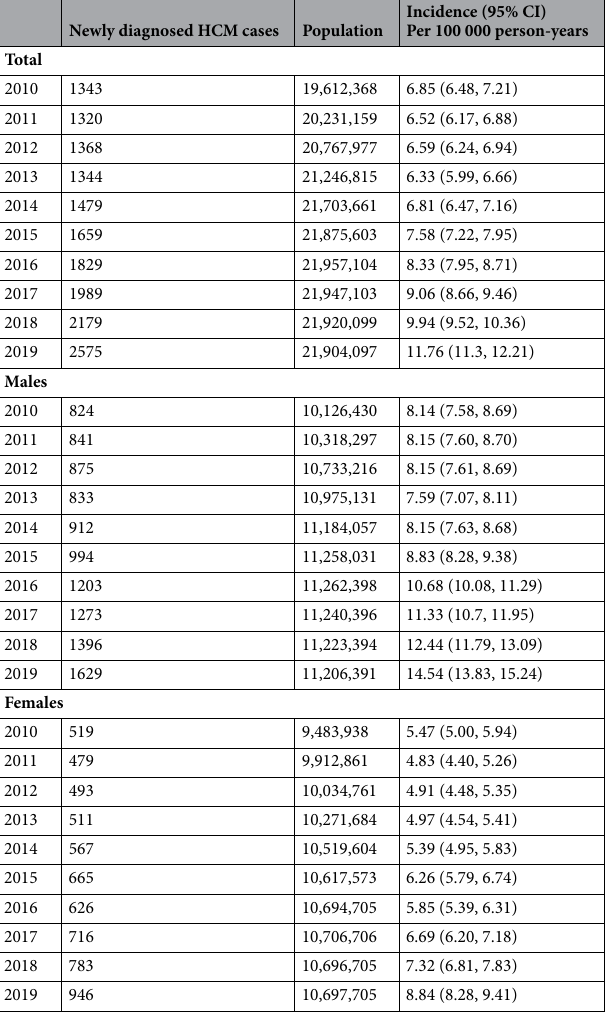
Table 1. Incidence of hypertrophic cardiomyopathy. HCM hypertrophic myocardiopathy.